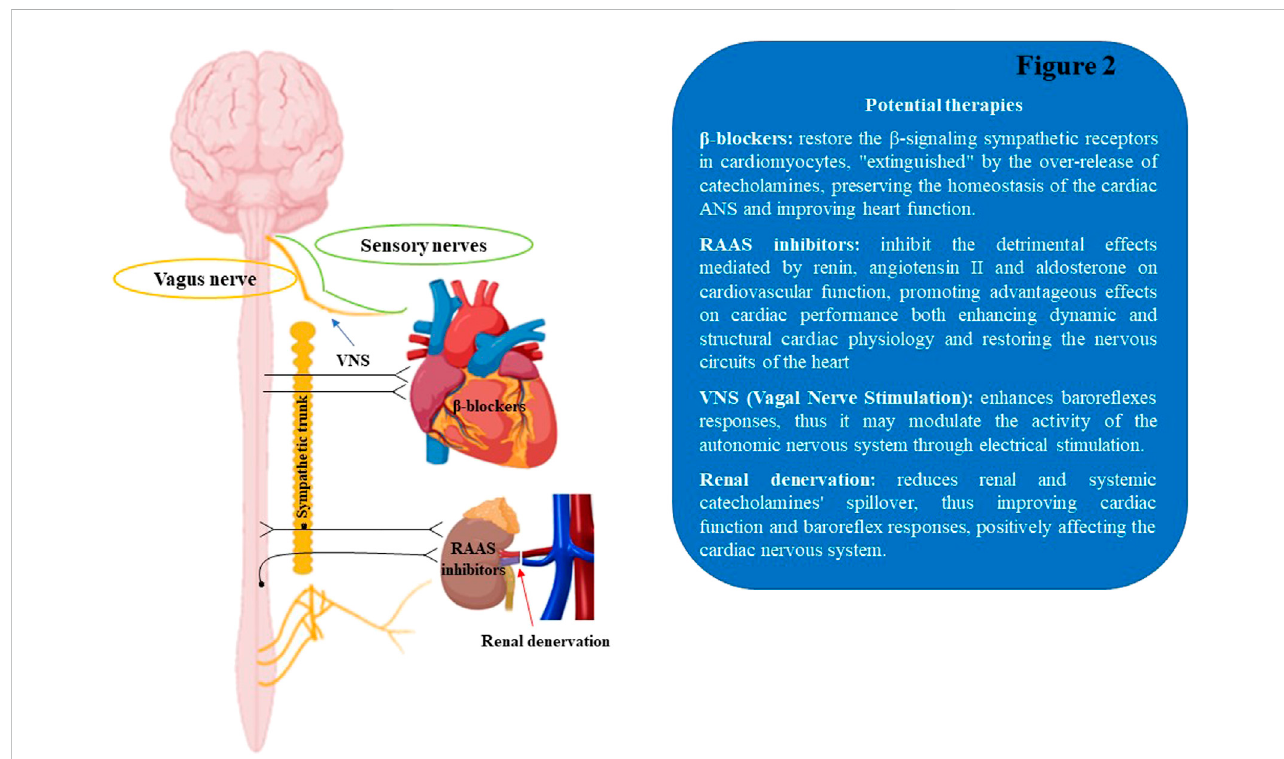
Schematicillustrationoftherapeuticapproachestomodulatethecardiacautonomicnervoussystem.RAAS,renin-angiotensinaldosteronesystem;VNS, Vagal Nerve